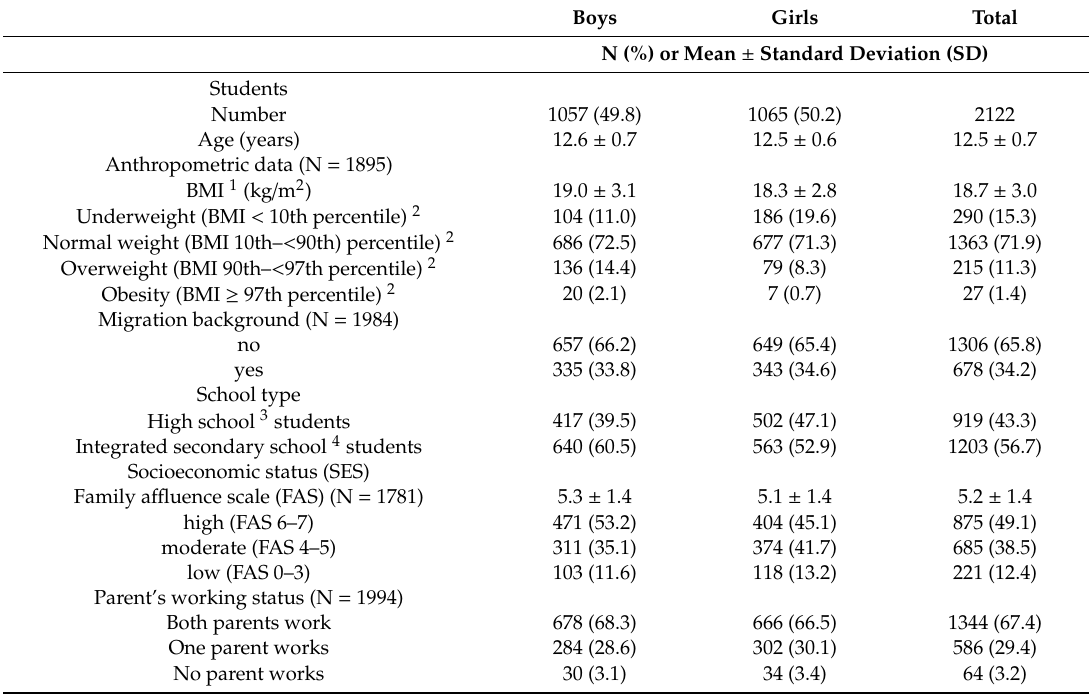
Table 2. Baseline characteristics of